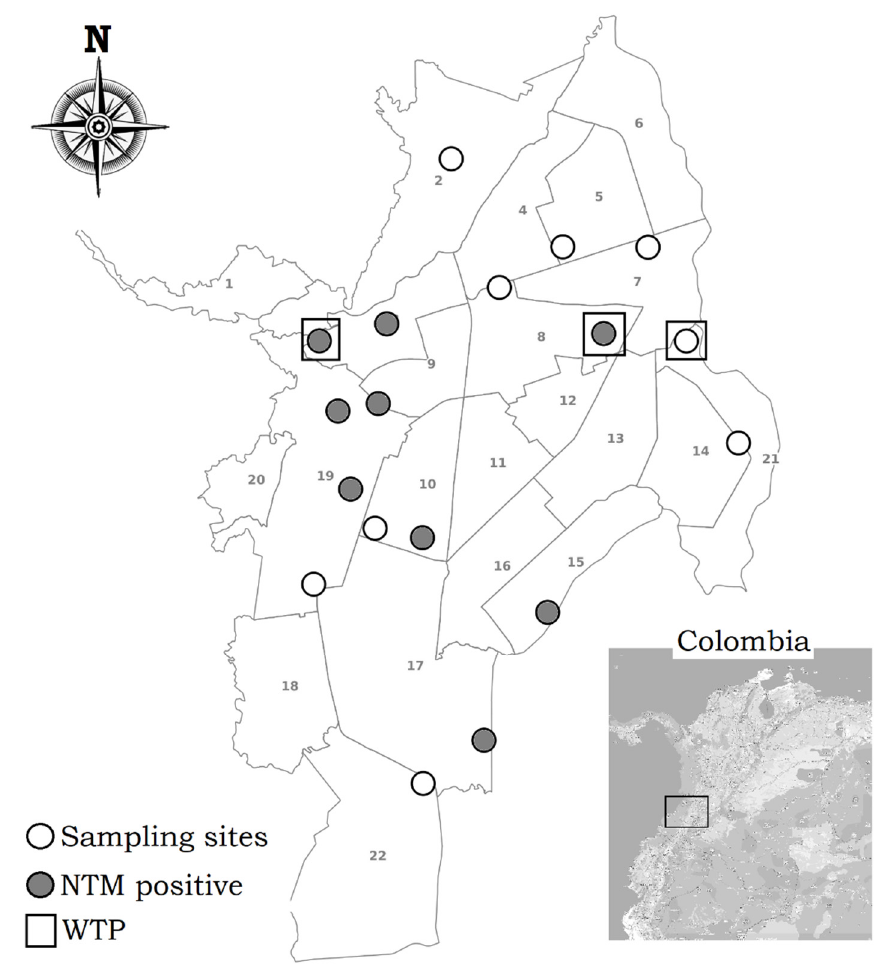
Figure 1. Location of sampling points in the city of Cali, Colombia. WTP, water treatment plant; NTM, nontuberculous mycobacteria. Numbers 1 to 22 represent division of the city in communes.